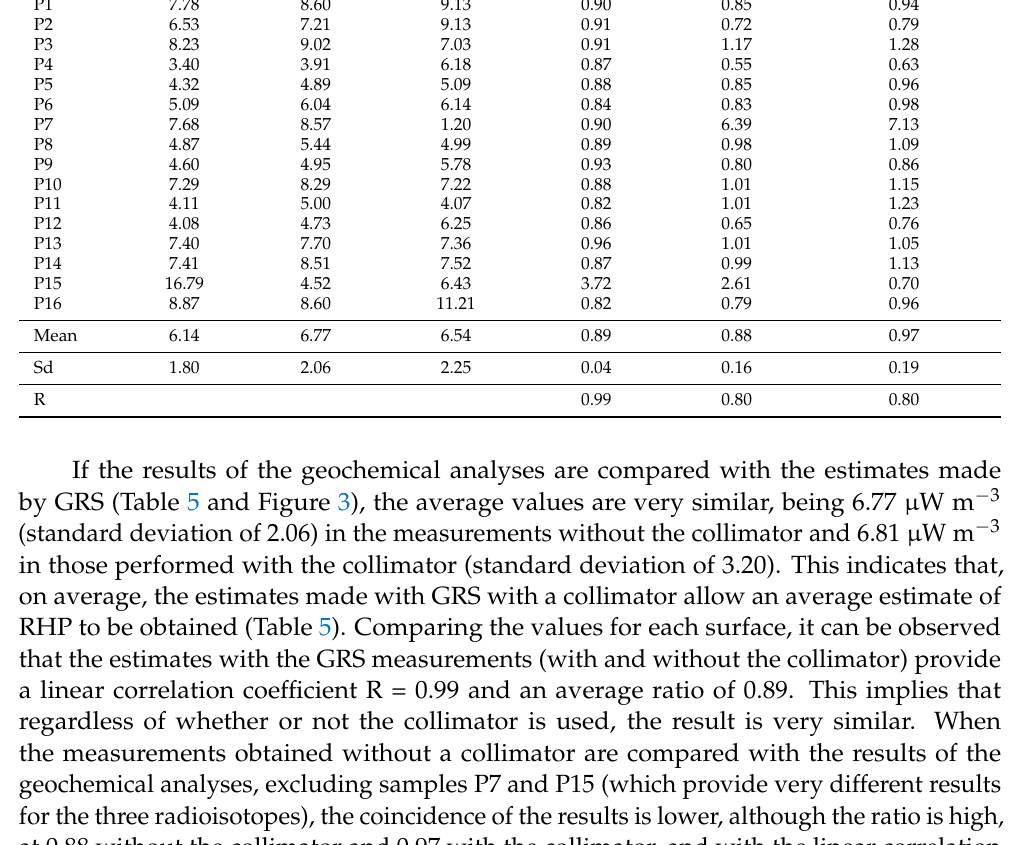
results oscillates between this value and the maximum, provided by samples P1 and P2 (both 9.10 µ W m − 3 ). Table 5. Radiogenic heat potential (RHP) and ratios of RHP estimates obtained via the different methods. GRS Sample